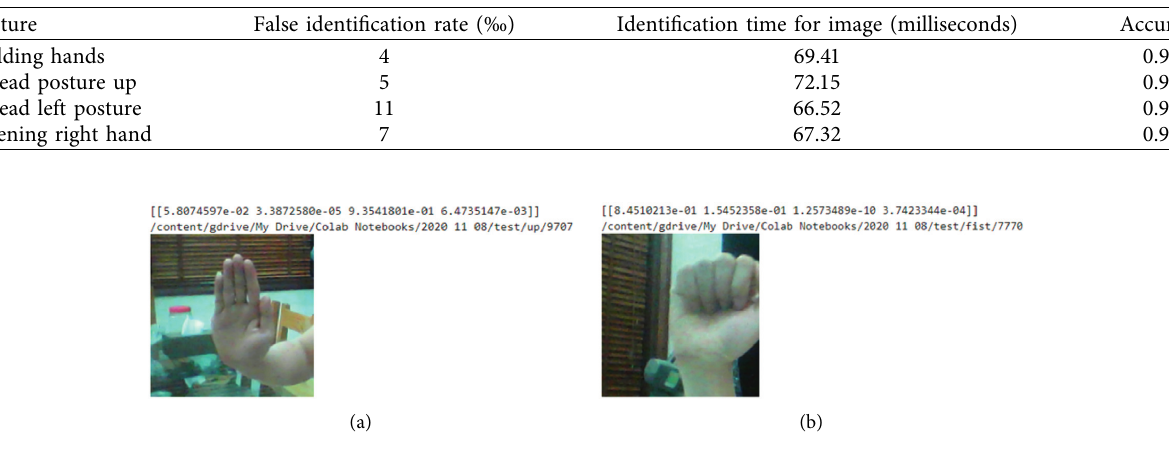
Figure 13: Results of detecting hand error for several cases: (a) face, (b) hair, (c) background, and (d) wrist. Table 4: Result of static posture recognition for 1000 images.